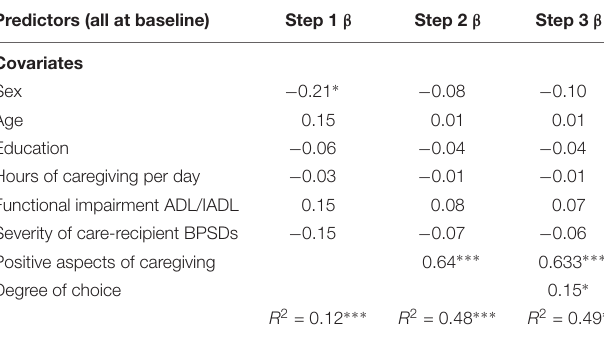
TABLE 4 | Hierarchical multiple regression analyses of Positive Aspects of Caregiving at